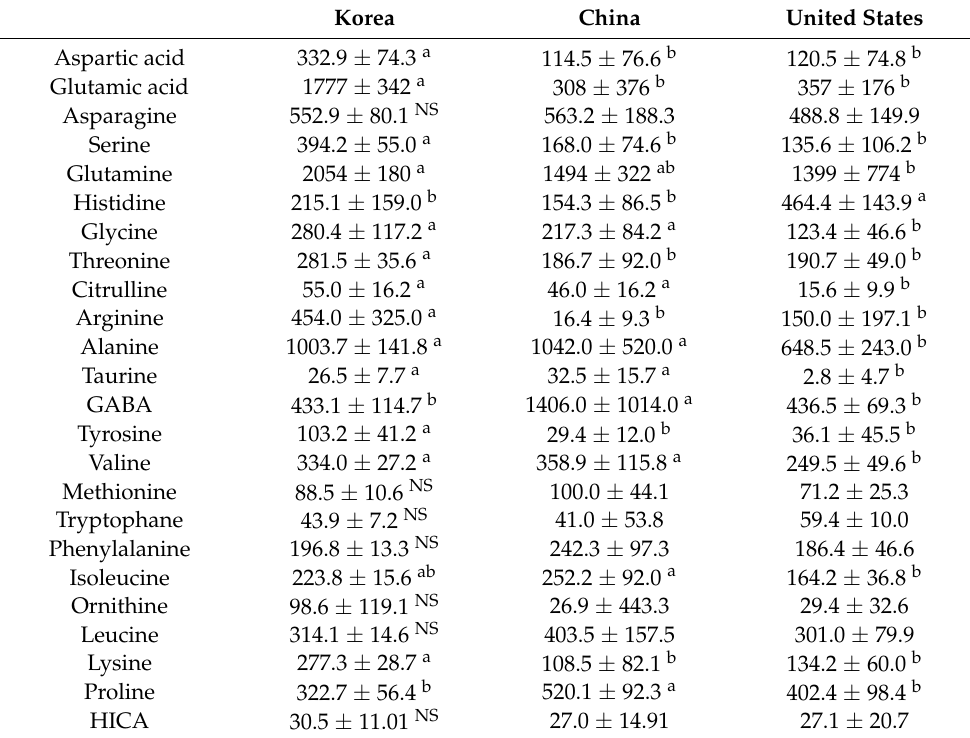
Table 5. Free amino acid contents of commercial kimchi manufactured in Korea, China, and the United States (mg/kg). Korea